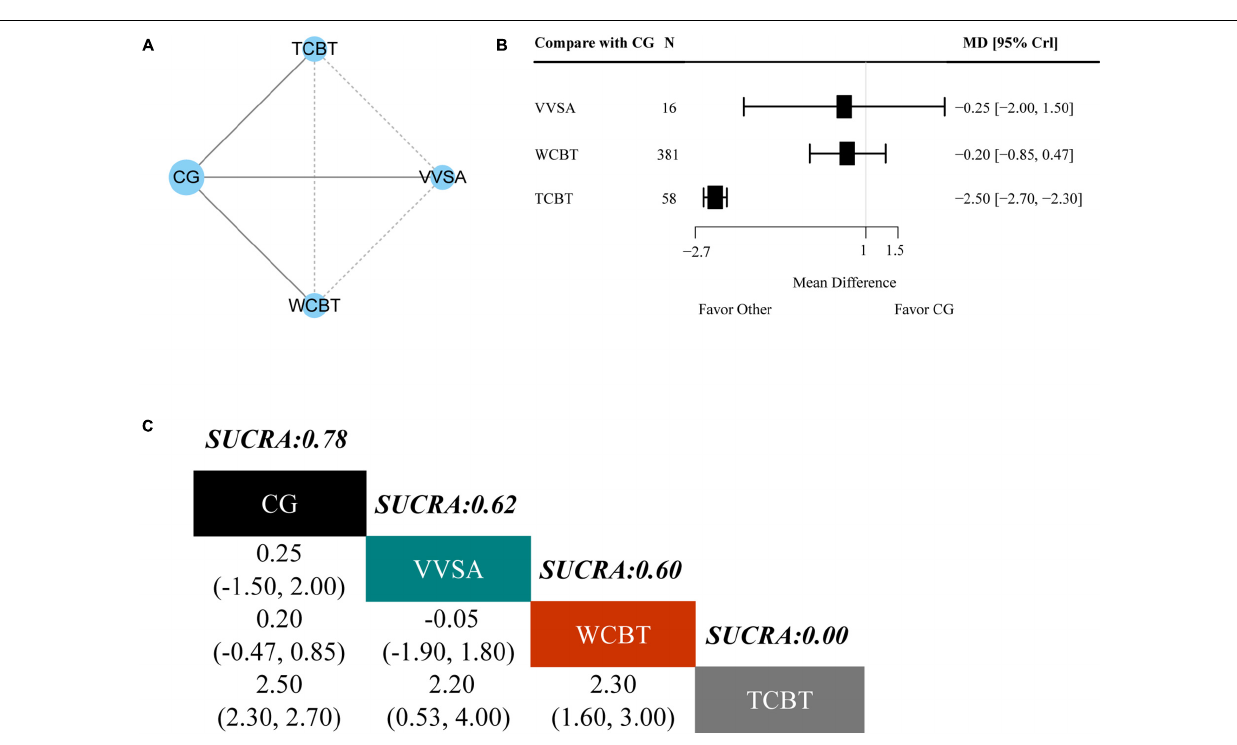
Frontiers in Behavioral Neuroscience |